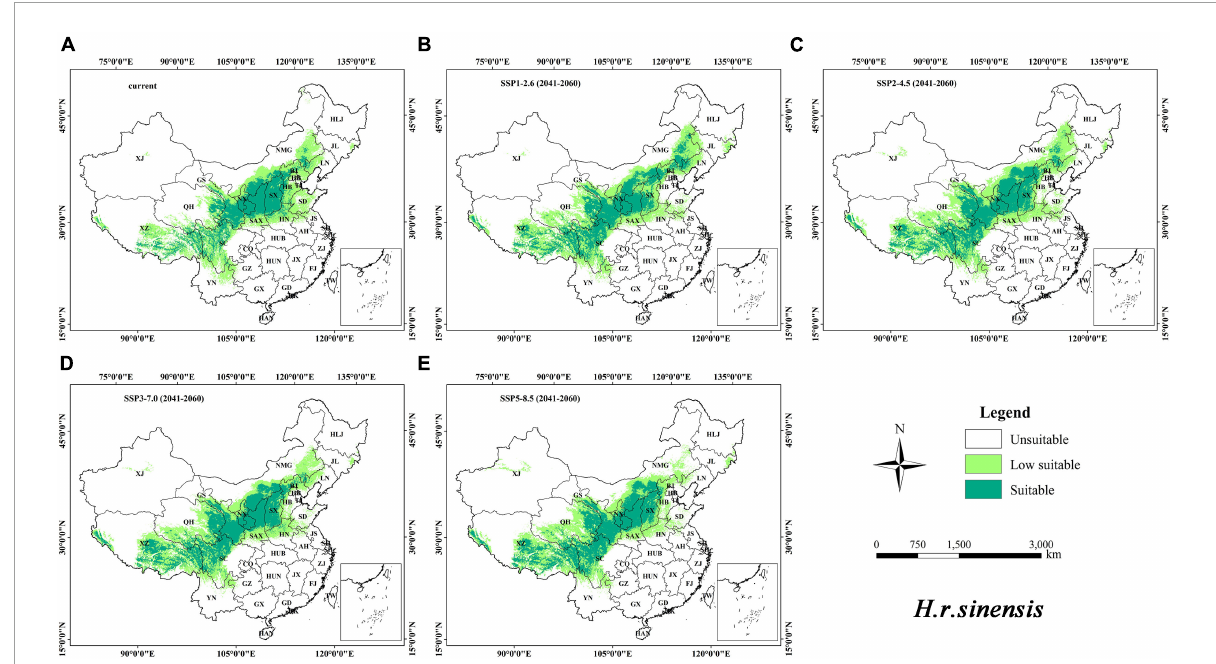
FIGURE4 Distribution of the suitable habitat of H. r. sinensis in China under different climate change scenarios. (A) current; (B–E) SSP1-2.6, SSP2-4.5, SSP3-7.0, and SSP5-8.5, in 2050S, respectively.